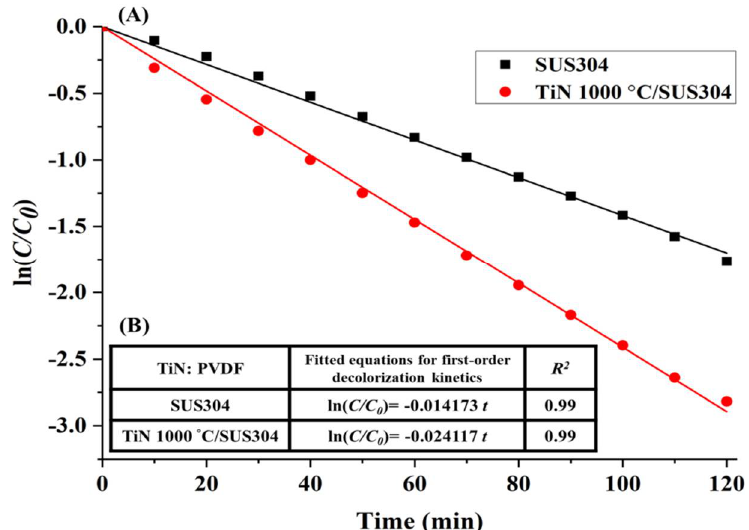
Figure 8. (A) First-order decolorization kinetics of the TiN 1000 °C/SUS304 electrode in the EF system; ( B ) Fitted equation for the first-order decolorization kinetics of the TiN 1000 °C/SUS304 electrode. Note: The solution contains 0.1 M KNO 3 , 20 ppm of Fe 2+ , and 5 ppm of RhB. The working potential was −800 mV, and the pH of the solution was adjusted to pH = 3 using 1 M HNO 3 .